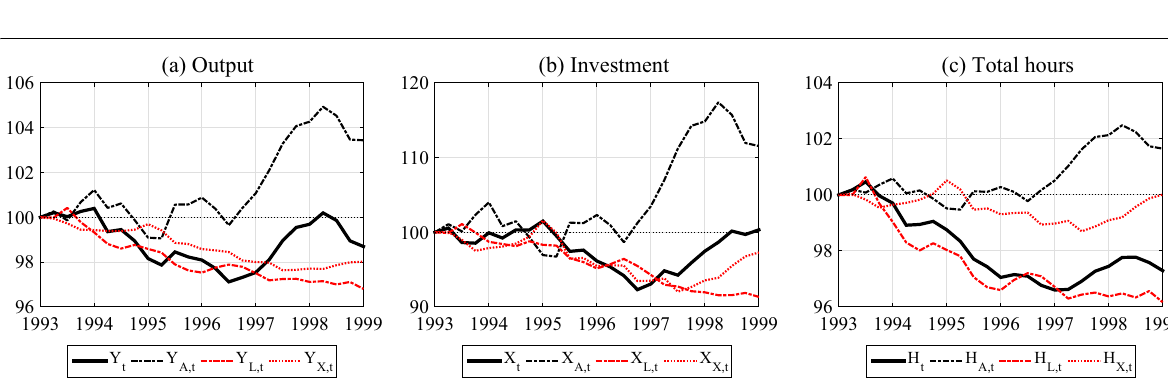
Fig. 5 Aggregates and their wedge-alone components 1993Q1–1999Q1. The subscripts A , L , X denote the efficiency-, labour-, and investment-wedge-alone component of output Y t , investment X t , or total hours H